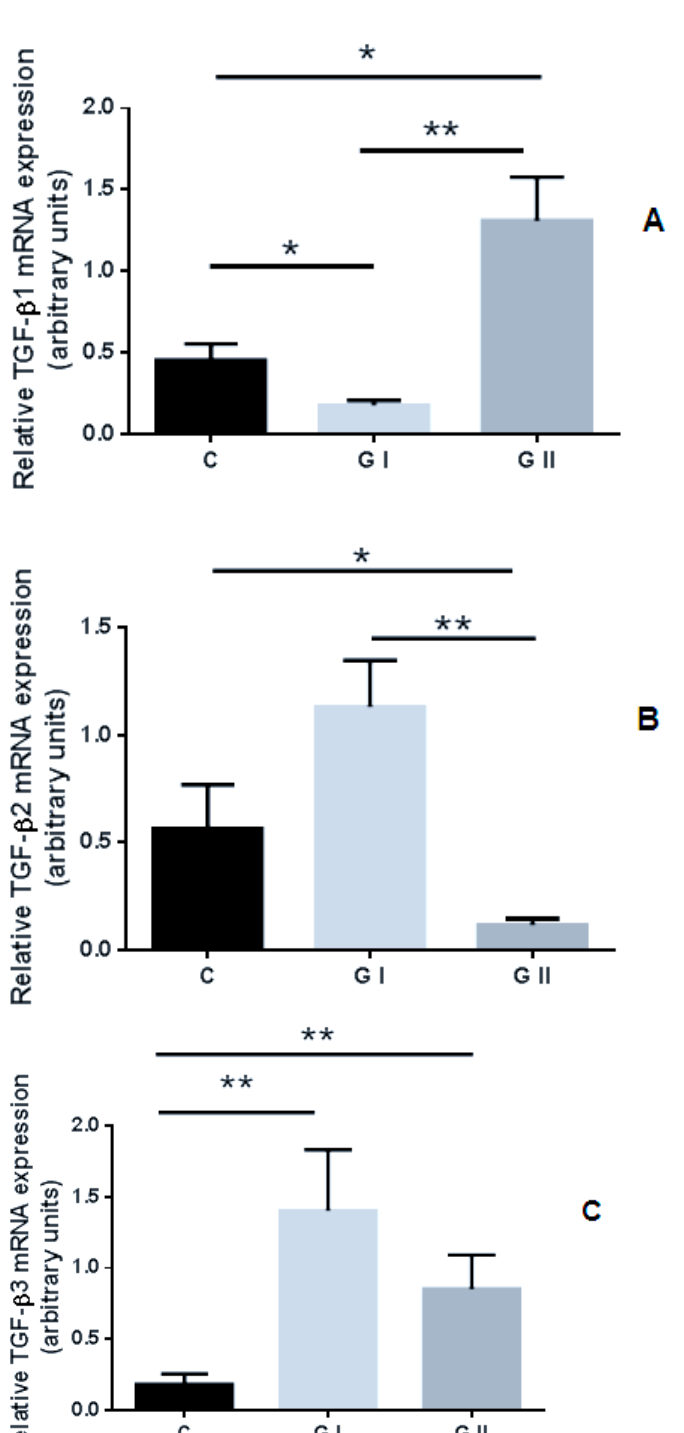
Figure 2. Relative expression of ( A ) TGF- β 1, ( B ) TGF- β 2, and ( C ) TGF- β 3 in canine endometrium with various proliferative and degenerative changes: cystic endometrial hyperplasia (GI) and CEH– pyometra (GII) compared to the standard physiological endometrium (C, control group). The data were normalized by dividing the expression of target genes by the expression of the housekeeping gene (GAPDH). All treatments were performed in triplicates and bars represent the mean ± SEM. The asterisks indicate significant differences as follows: *, p < 0.05; **, p < 0.01.